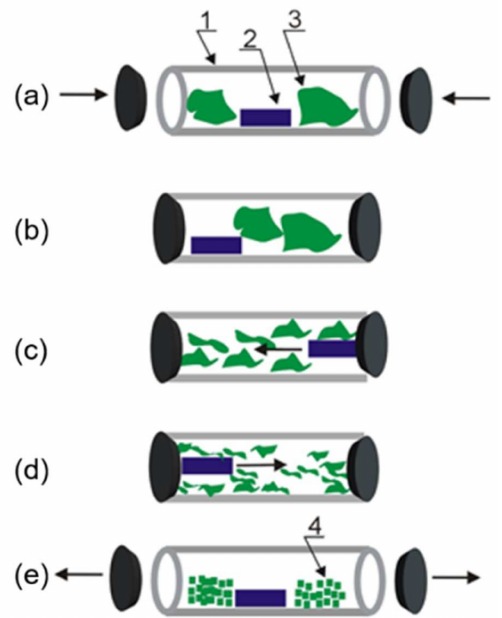
Figure 1. Scheme of the subsequent stages of milling process: ( a ) loading the sample into the vial, ( b ) closing the vial, ( c ) starting the grinding process, ( c , d ) sample grinding by magnetically shuttling impactor oscillating back and forth along the vial, and ( e ) removing powder from the vial. The numbers in the diagram label sequentially (1) the vial, (2) impactor, (3) sample, and (4)